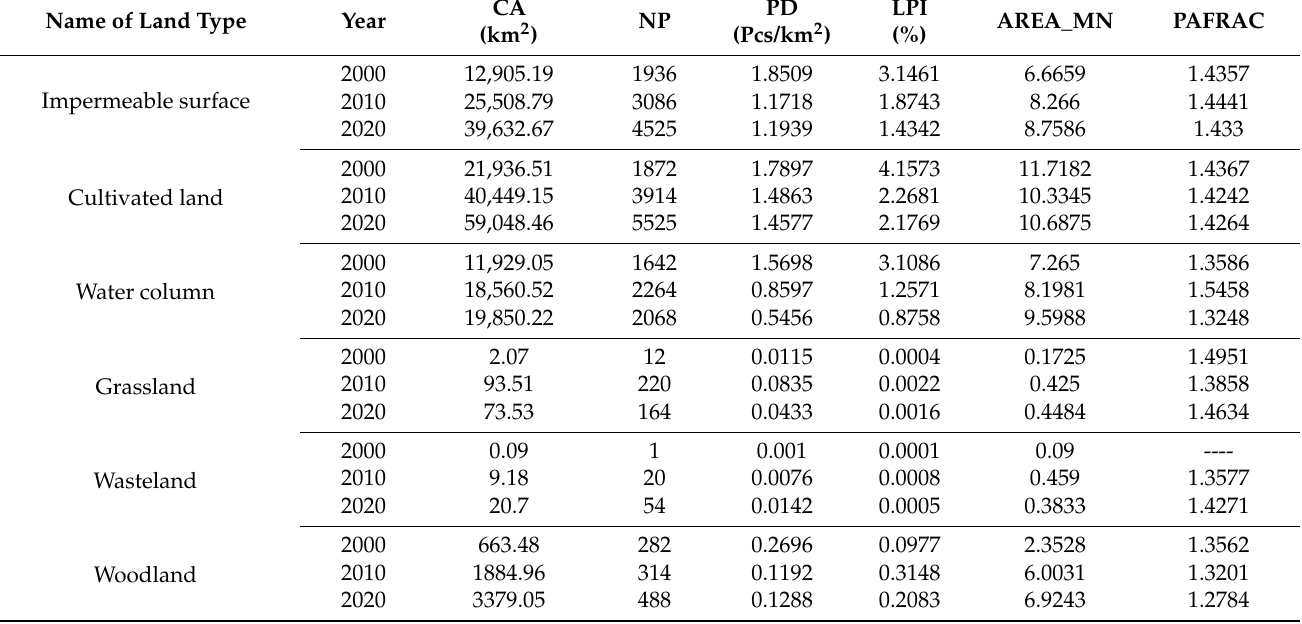
Table 14. Land-use landscape type-level index for urban fringe in Wuhan,